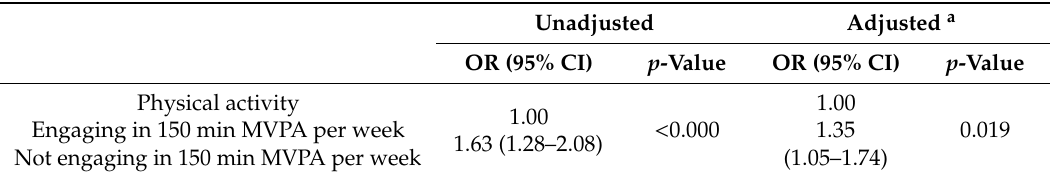
Table 2. Independent associations between objectively measured physical activity and cognitive function in elderly